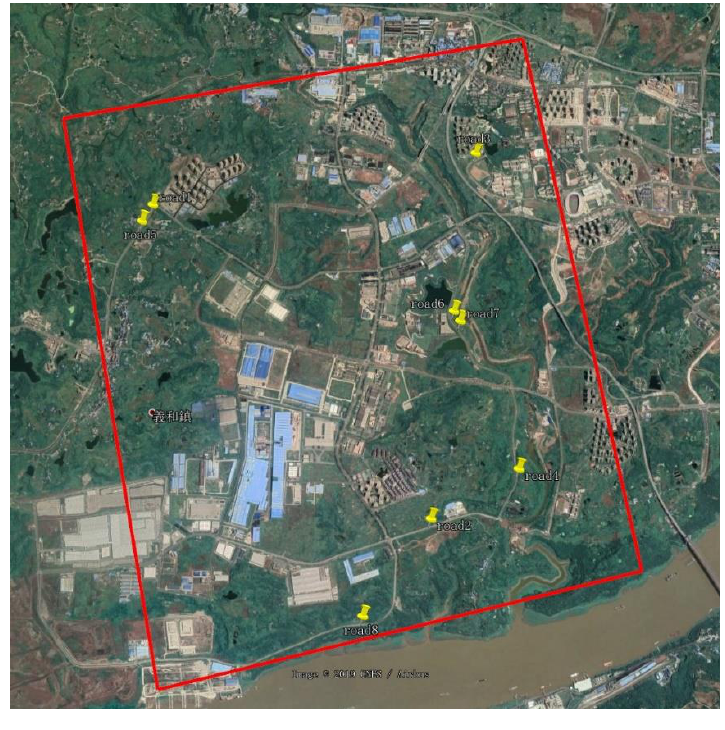
Figure 16. Test sites. Table 1. Basic information about the selected eight road segments.